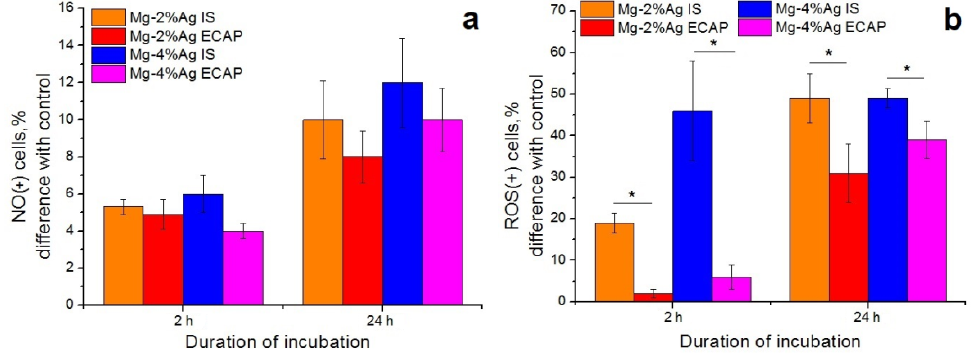
Figure 10. Production of NO ions ( a ) and reactive oxygen species (ROS) ( b ) by tumor cells during co-incubation with samples of Mg-2.0%Ag and Mg-4.0%Ag alloys in the initial state and after ECAP (regime 2, which is associated with oxidative stress in the cells in comparison with the control (* p < 0.05).